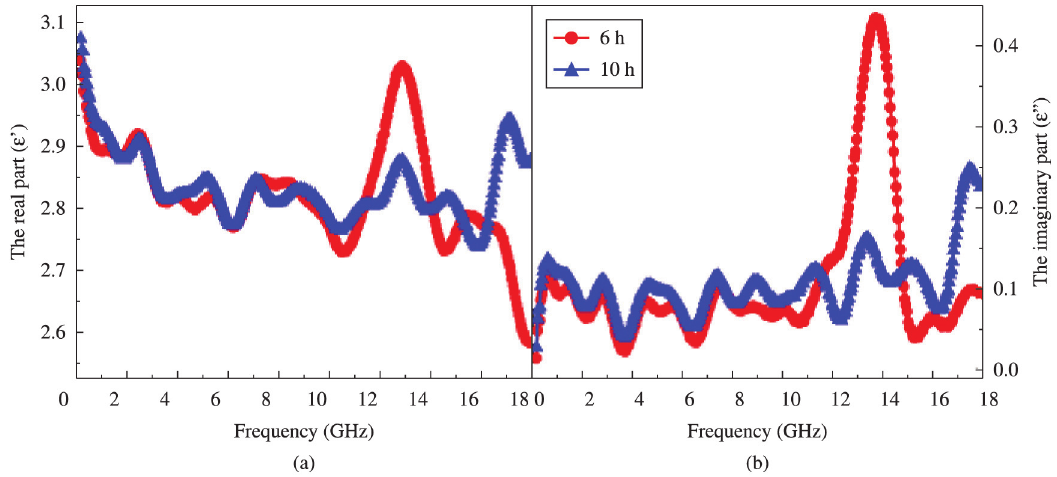
Figure 5. (a) the real part ( ε′ ) and (b) the imaginary part ( ε′′ ) of relative complex permittivity for the Co(OH) heating time of 6 h and 10 h,